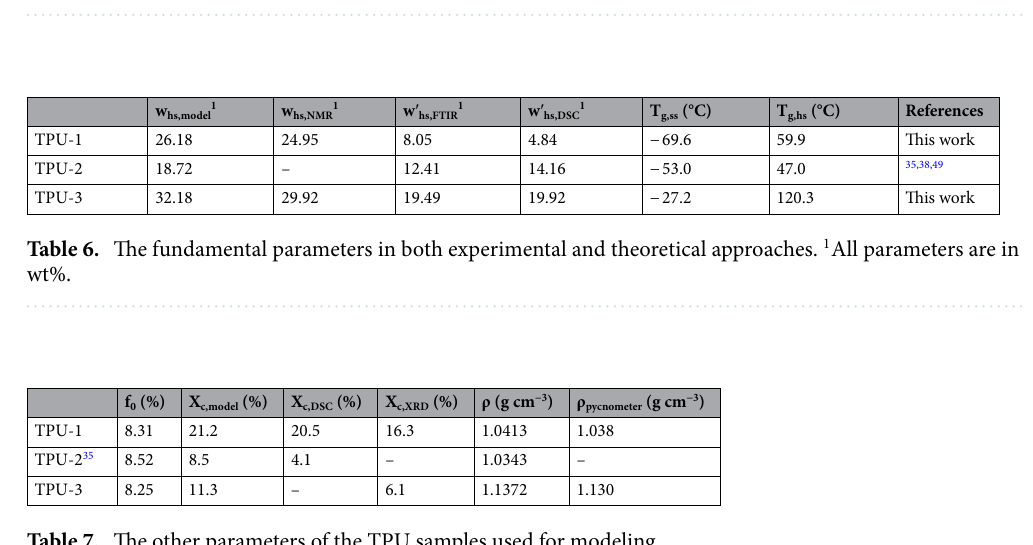
Table 5. The transition temperature and viscoelastic parameters of the DMTA analysis at a frequency of 1 Hz and T ref = 25 °C. 1 Based on the inflection of storage modulus (E ′ ) curve.